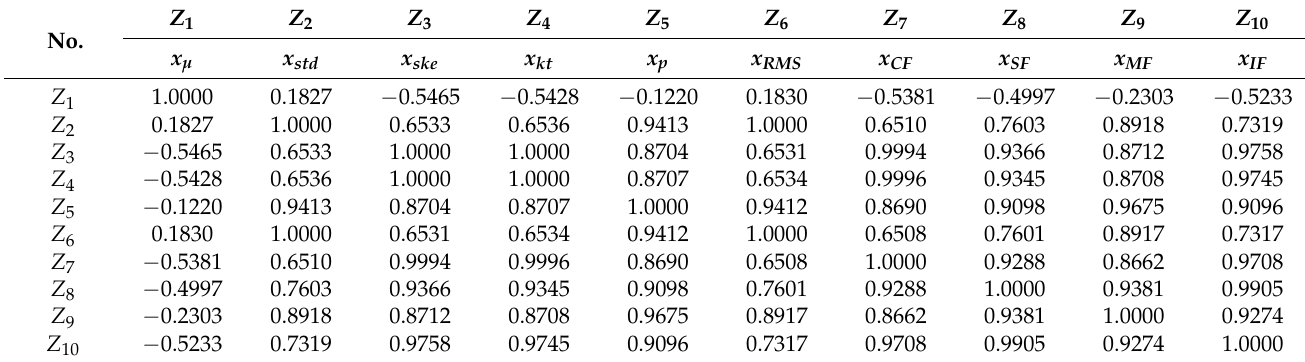
Table 4. Correlation matrix between standardized SCI for the normal data in training set.